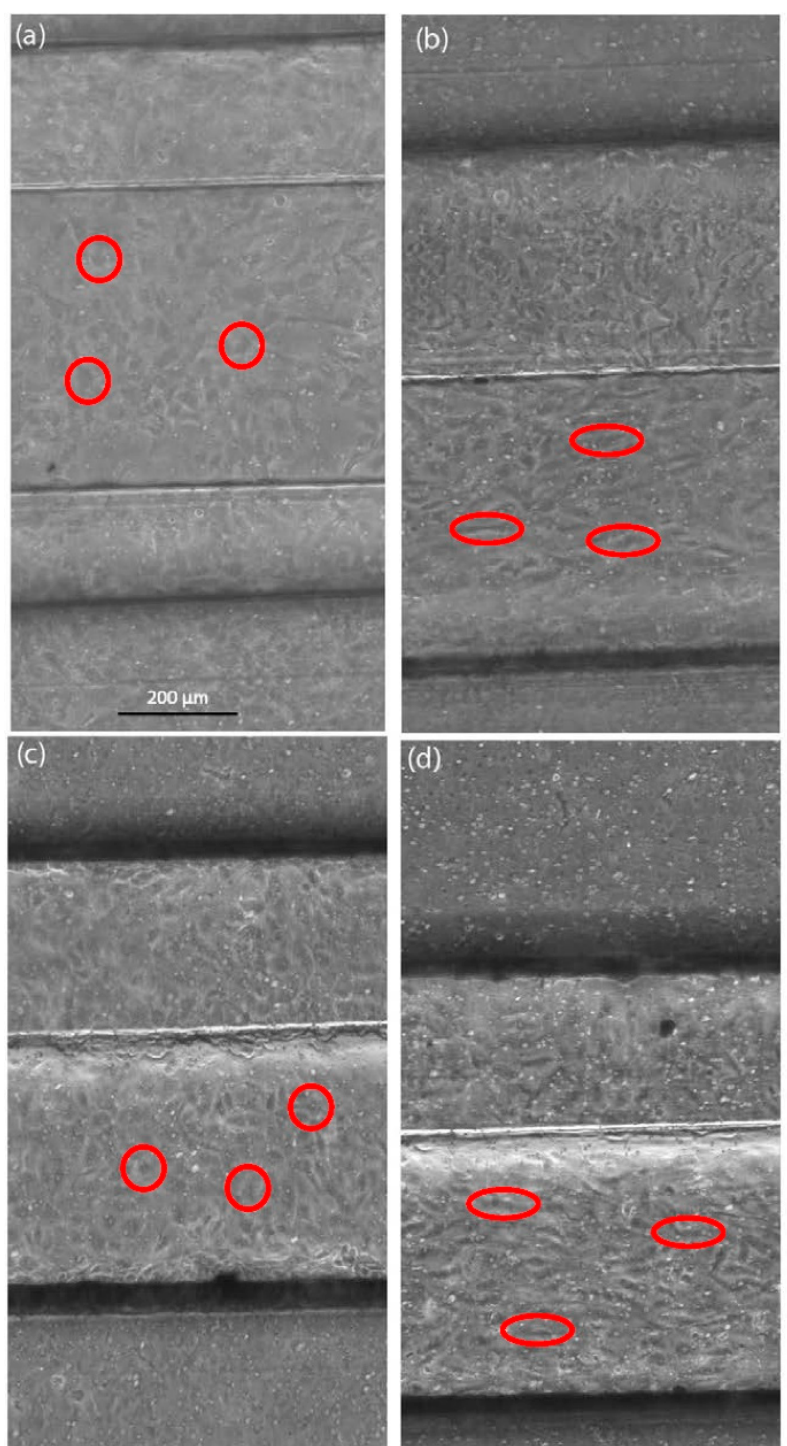
Figure 4. Live cell images of endothelial cells in the microfluidic device, perfusion flow velocity 24 mm/s. ( a ) Image of endothelial cells at the start of the continuous flow experiment; ( b ) Endothelial cells after continuous flow over 48 h; ( c ) Image of endothelial cells at the start of the pulse flow experiment; ( d ) Endothelial cells after the pulse flow perfusion at a rate of 60/min over 72 h. Before the flow is introduced, endothelial cells have a roundish shape (red circles). Endothelial cells show morphological changes, like elongation and orientation, into the direction of flow (red ovals), which might be influenced by the shear stress of the continuous or pulsating flow.